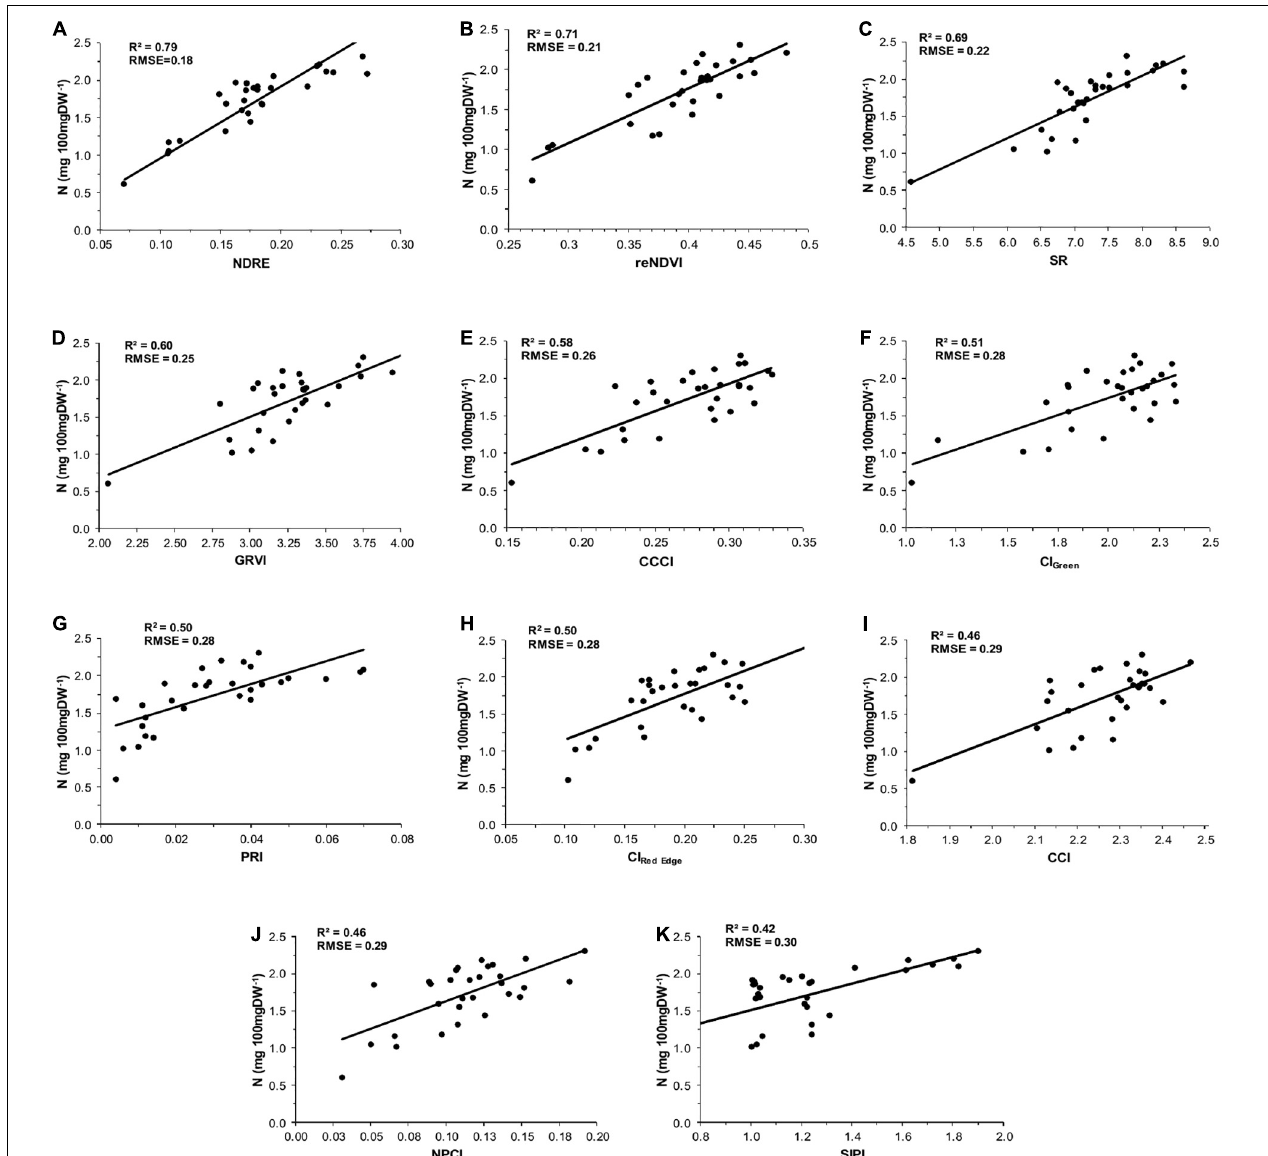
FIGURE 3 | Relationship between foliar nitrogen concentrations and vegetation indexes: (A) normalized difference red edge (NDRE), (B) red edge normalized difference vegetation index (reNDVI), (C) simple ratio (SR), (D) green-red vegetation index (GRVI), (E) canopy chlorophyll content index (CCCI), (F) green chlorophyll index (CI Green ), (G) photochemical reflectance index (PRI), (H) red edge chlorophyll index (CI Red Edge ), (I) canopy chlorophyll index (CCI), (J) normalized pigment chlorophyll ratio index (NPCI), and (K) structure insensitive pigment index (SIPI) in menthol